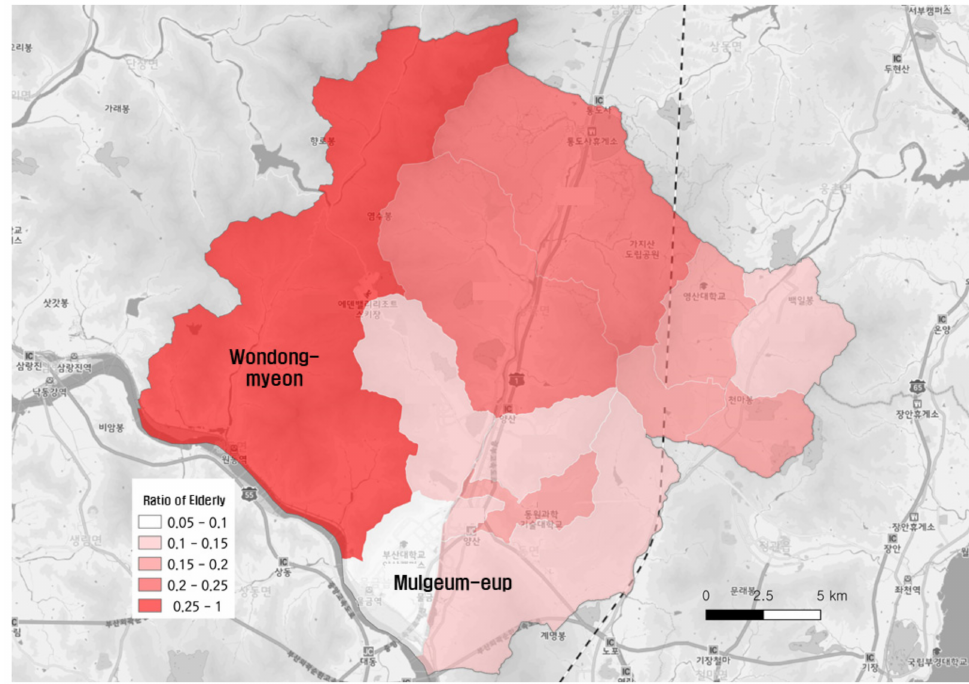
Figure 5. The proportion of the elderly population by administrative districts in